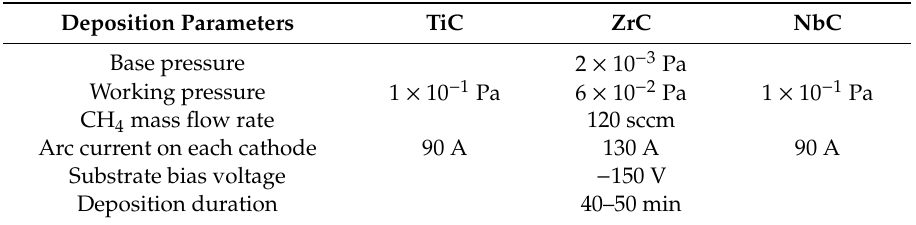
Table 1. Depositions conditions for the developed